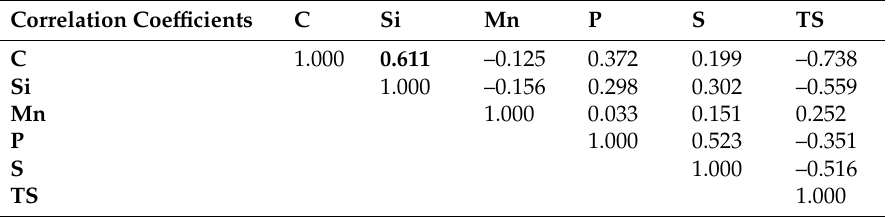
Table 2. Correlation coe ffi cients between all input and output variables. TS: tensile